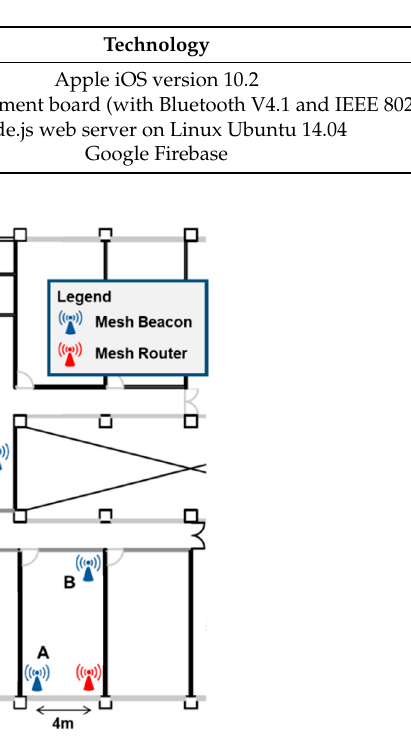
Figure 7. Deployment of BLE beacon network with 4 Mesh Beacons and 1 Mesh Router.